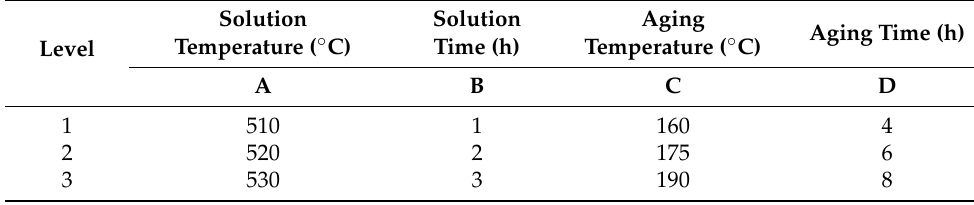
Table 1. Factor levels of the orthogonal